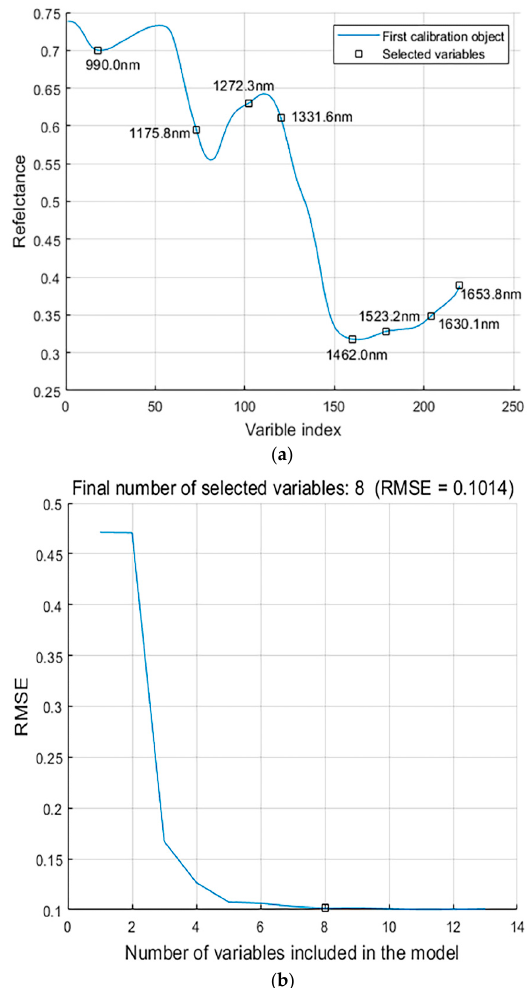
Figure 6. Process of selecting characteristic wavelengths based on successive projections algorithm (SPA). ( a ) Final number of selected variables according to the minimum root mean square error of validation (RMSEV) in the validation set of multiple linear regression (MLR); ( b ) the selected characteristic wavelength marked with a black square.